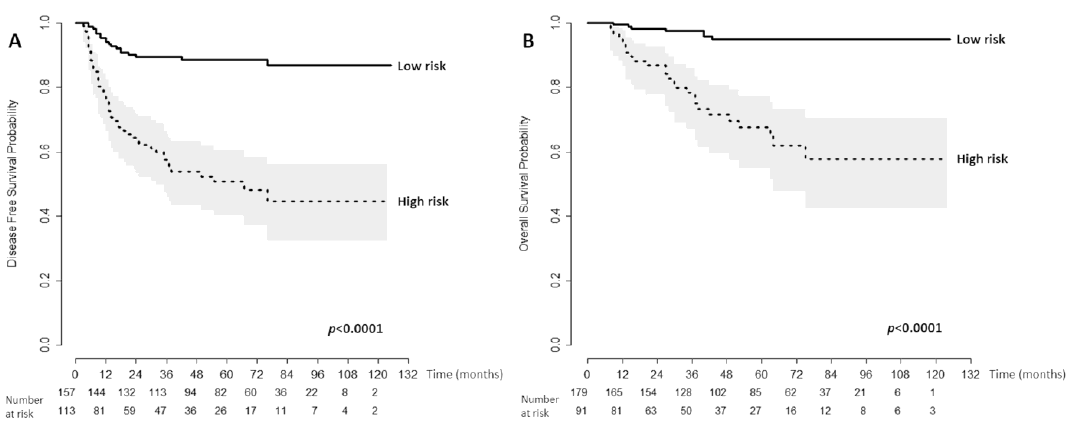
Figure 3. Kaplan–Meier disease-free survival ( A ) and overall survival curves ( B ) for high-risk and low-risk